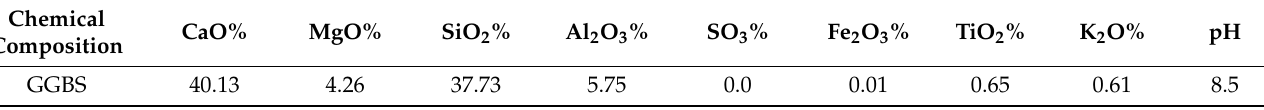
Table 2. GGBS—chemical composition and pH.